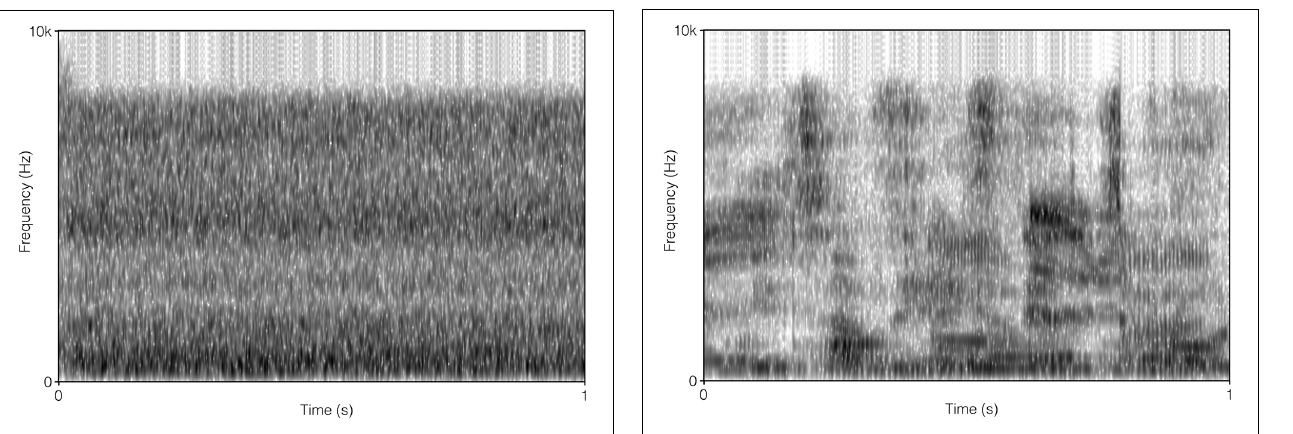
FIGURE 2 | Spectrogram of 1s of steady-state broadband noise. FIGURE 3 | Spectrogram of 1s of four-talker